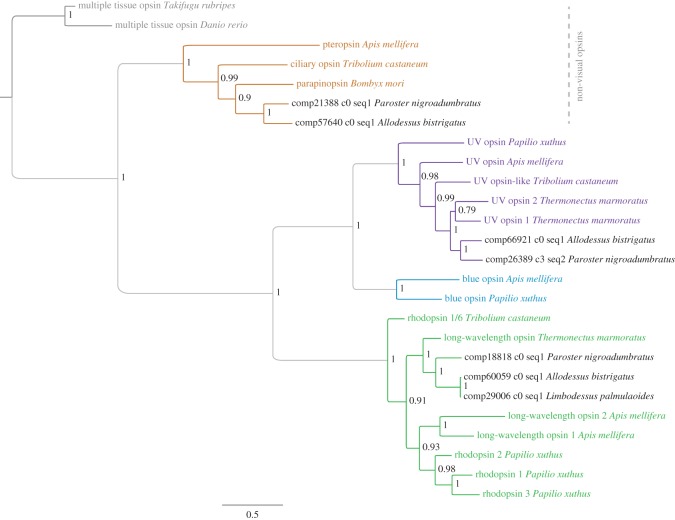
Opsin phylogeny. Majority rule consensus tree of visual and non-visual opsin photoreceptors derived from Bayesian inference, with posterior probability node support. Tree branches and terminal taxa are colour coded to identify Candidate Set opsin gene class from figure 1: ciliary (brown), UV (violet), blue (blue), long wavelength (green) and outgroups (dark grey).